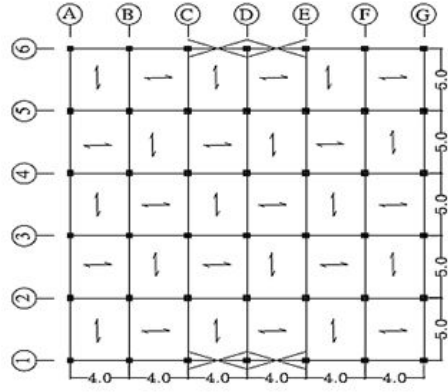
Figure 1: Elementary plan of structural floors